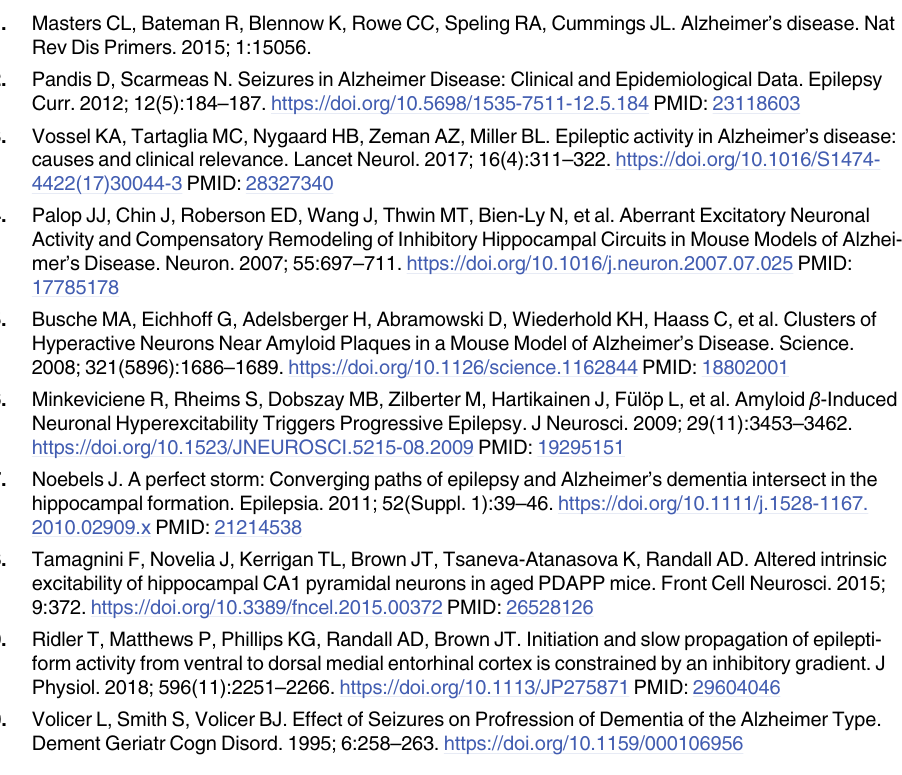
S1 Table. A list of ROIs for parcellation of source data, based on the coarse grained Brain- netome atlas [63] used in Tait et al. (2019) [33]. For each ROI, we give a full name, and the abbreviation used in Fig